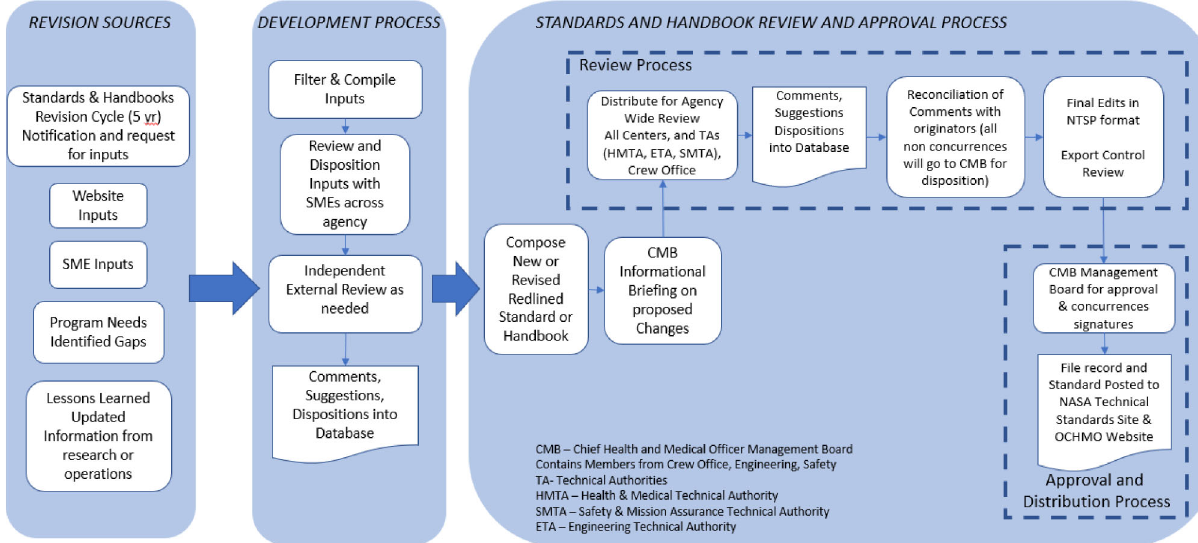
Fig. 4 Development and revision process for OCHMO standards and handbooks. The purpose of this graphic is to give readers a better understanding of the process used to revise and approve NASA-STD-3001 and associated